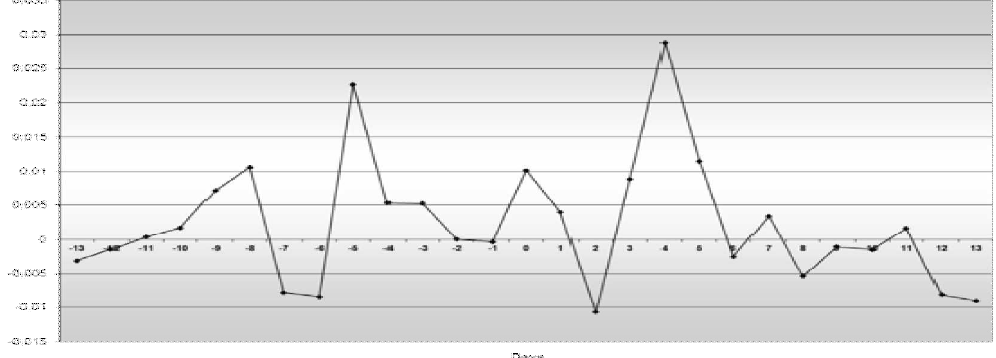
Fig. 5 . Abnormal returns in the market model (normal stock splits)